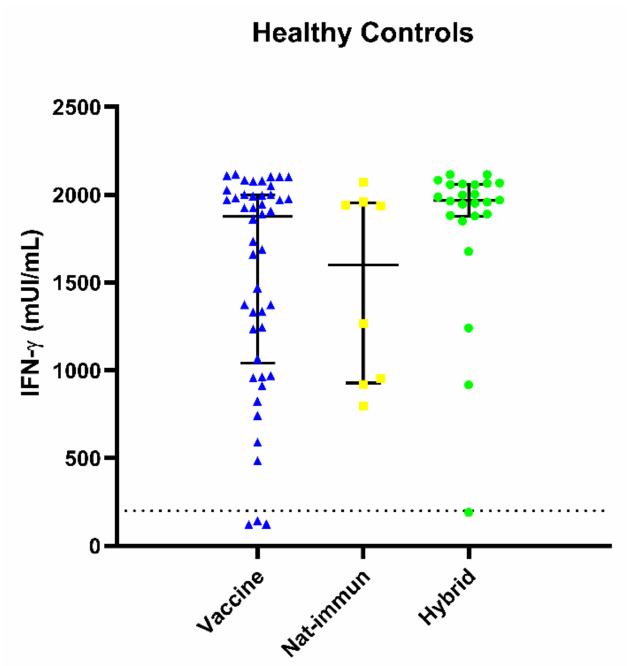
Figure 3. Specific anti-SARS-CoV-2 IFN- γ levels in healthy control (HC) subgroups (vaccine showed in blue, natural immune response in yellow and hybrid in green) assessed by IGRA. There was great variability in the HC-vaccine subgroup in comparison with the other subgroups, and the highest titers were observed in the HC-hybrid